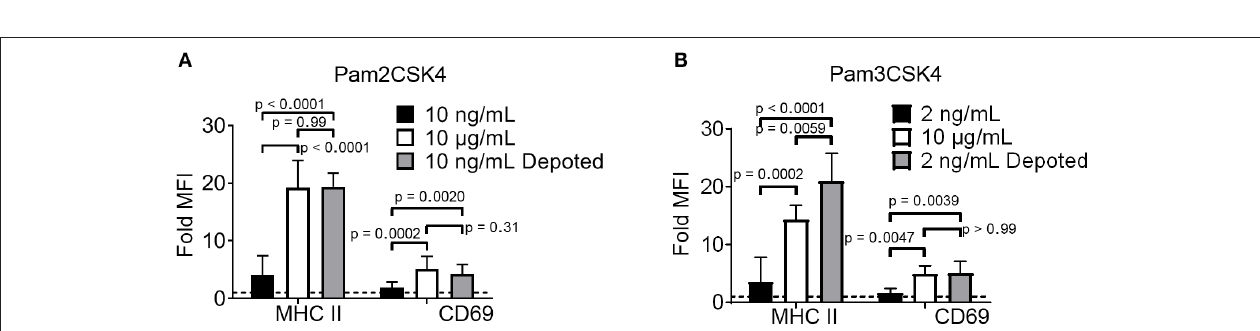
FIGURE 3 | Depoting of TLR ligands provides dose control. Depoted lipid-tailed TLR ligands into polyclonal T cells was dependent on input concentration for (A) lipid-CpG; and (B) Pam2CSK4 or Pam3CSK4 polypeptides. The fold increase in average ligand per T cell is indicated per ELISA analysis. p -values between indicated comparisons as determined by two-way ANOVA with Sidak’s tests. Data showed mean ± s.d. ( n = 3–4 independent samples).